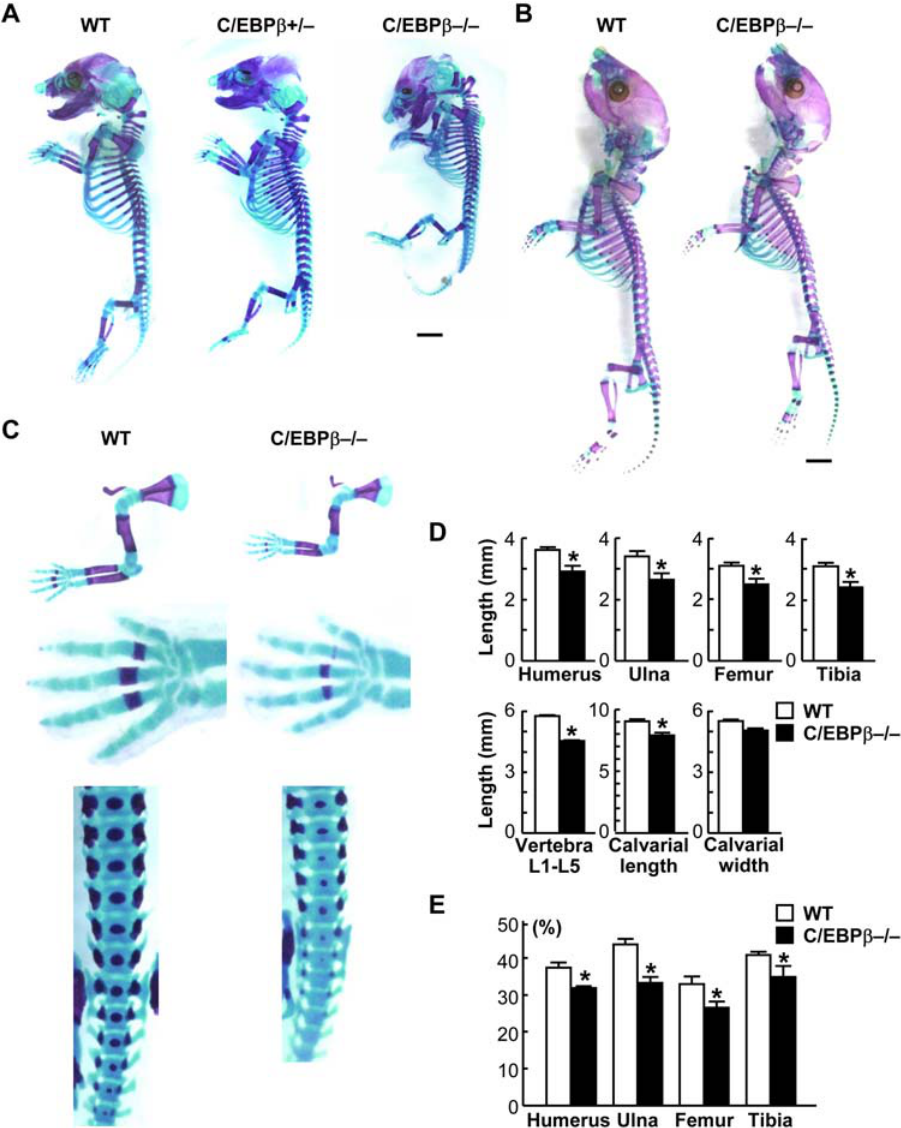
Figure 1. C/EBP b 2 / 2 mice exhibit impaired skeletal growth and endochondral ossification. (A, B) Double stainings with Alizarin red and Alcian blue of the whole skeleton of the wild-type (WT), C/EBP b + / 2 , and C/EBP b 2 / 2 littermates at E16.5 (A) and at 3 d after birth (B). Scale bar, 2 mm. (C) Double stainings of the upper limbs, hands, and lumbar spines of the two genotypes. (D) Length of humerus, ulna, femur, tibia, vertebra (1st to 5th lumbar spines), and the calvarial length and width of the WT and C/EBP b 2 / 2 littermates. (E) The percent ratio of Alizarin